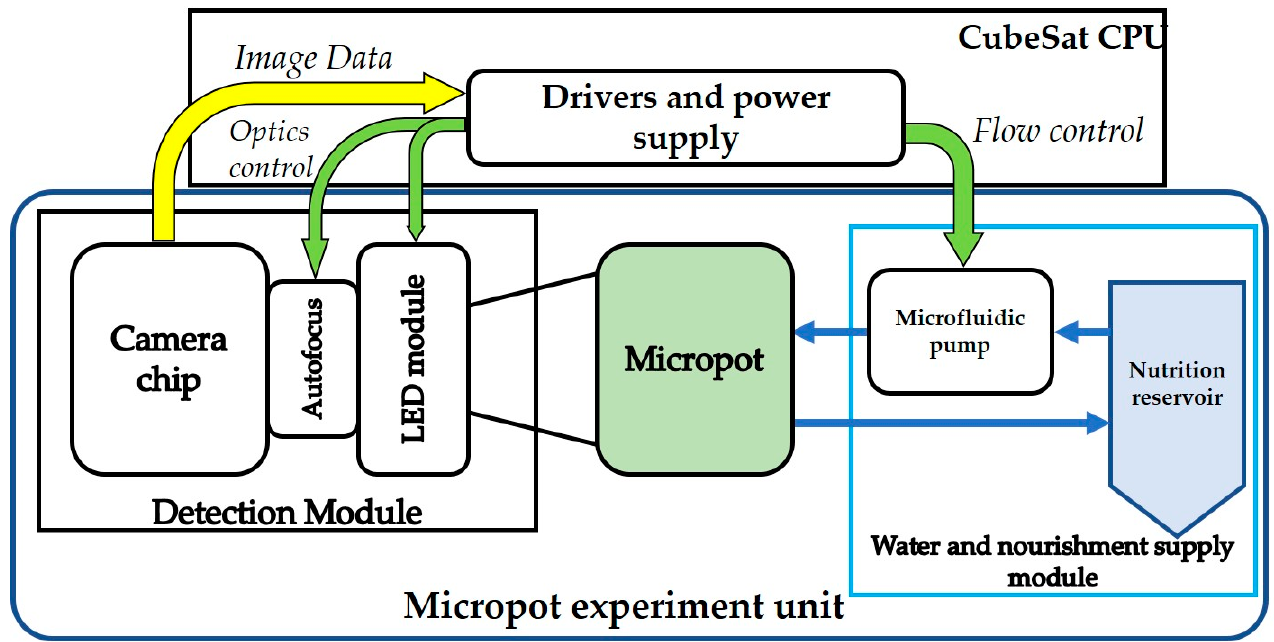
Figure 1. Scheme of the micropot nanosatellite payload.